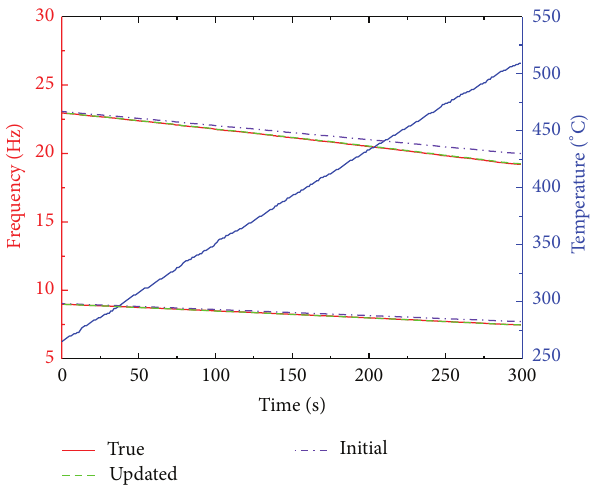
Figure 6: The first two instantaneous natural frequencies of beam B and transient temperature.